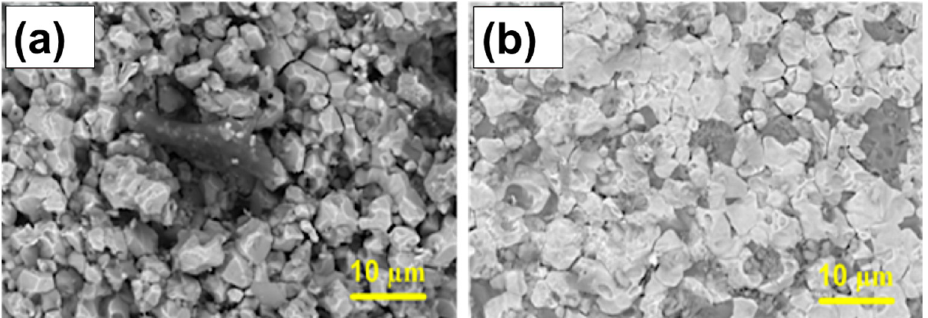
Figure 10. Fracture morphology of investigated samples: ( a ) sample no. (W-Ni-Fe-Y 2 O 3 ) sintered at 1300 °C and ( b ) sample no. five (W- Ni-Fe-Co-Y 2 O 3 ).